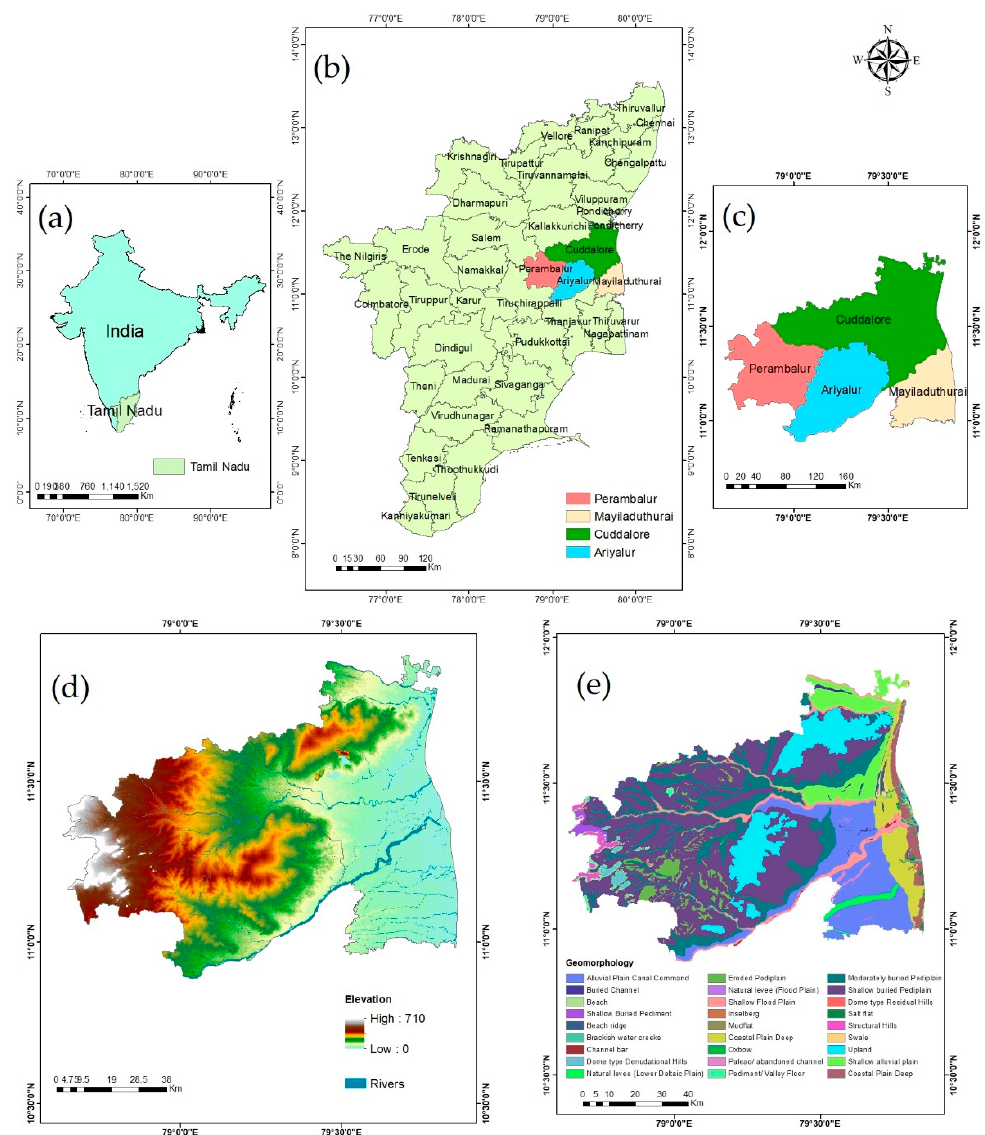
Figure 1. ( a , b ) Locational information of the study area in Tamil Nadu; ( c ) Study area map; ( d ) Dig- ital elevation model (DEM); ( e ) Geomorphology. elevation model (DEM); ( e )